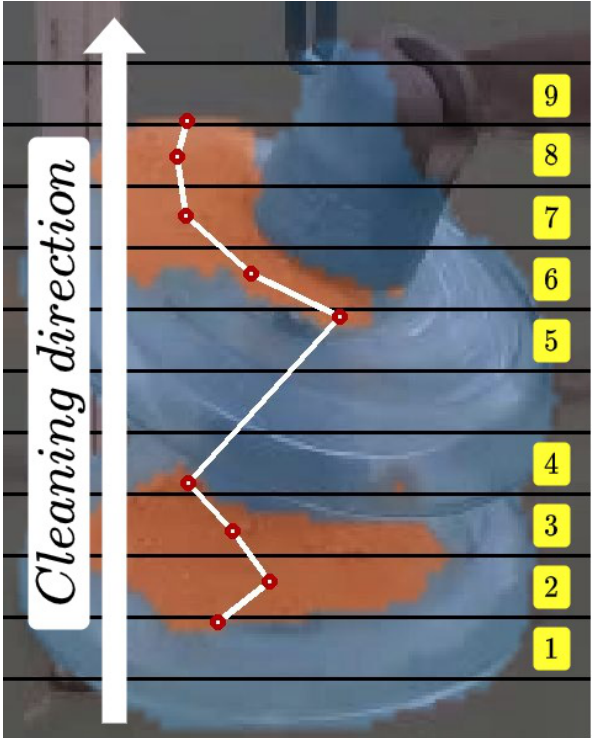
Figure 8. Soiled area segmentation and cleaning trajectory generated by the algorithm.